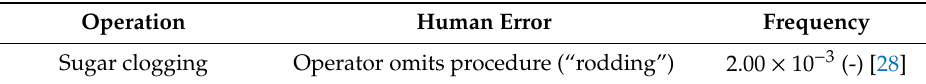
Table 6. Human errors involved.